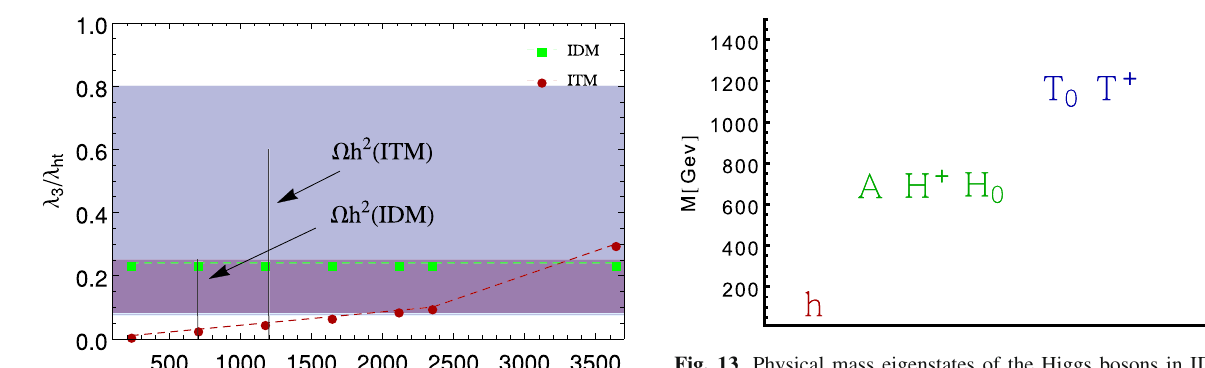
Fig. 13 Physical mass eigenstates of the Higgs bosons in IDM and ITM corresponding to lightest possible DM mass satisfying the correct DM relic. h is the 125.5 GeV SM-like Higgs boson. Green colour cor- responds to physical mass eigenstates in IDM. where A is DM with = 702 . 364 GeV, M = 708 . 314 GeV M A = 700 . 18 GeV and M ± H 0 H = 1176 . 00 respectively. For ITM the lightest possible DM mass is M T 0 GeV along with almost degenrate charged Higgs mass M T ± = 1176 . 16 GeV represented in blue